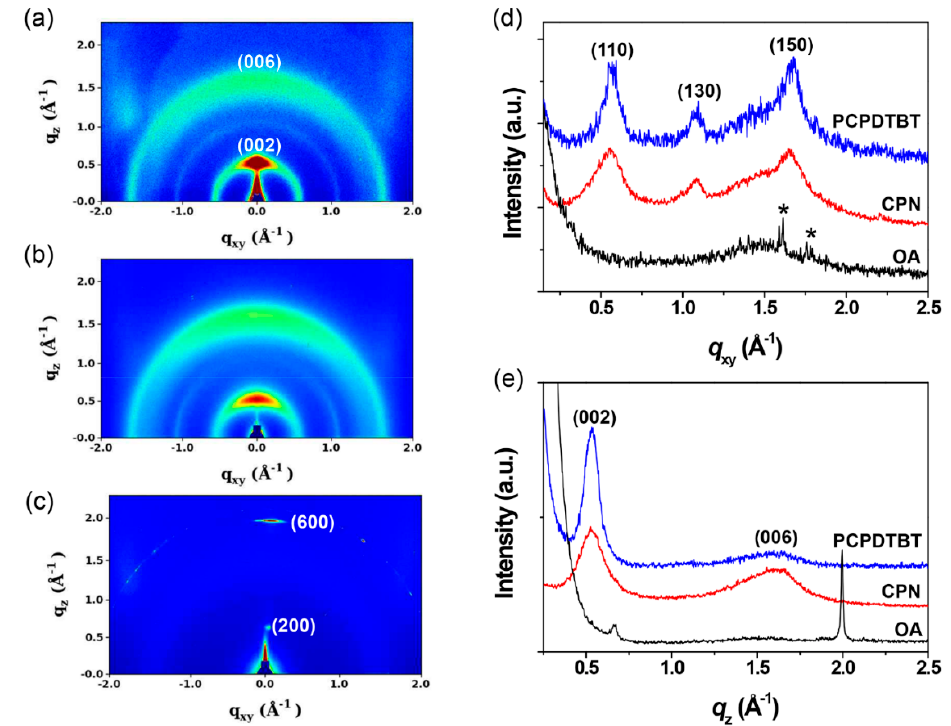
Figure 2. 2D GIXD patterns of ( a ) PCPDTBT film, ( b ) CPNs, and ( c ) OA film, and corresponding ( d ) in-plane and ( e ) out-of-plane GIXD profiles. The asterisks (*) in ( d ) indicate diffraction peaks from the substrate.